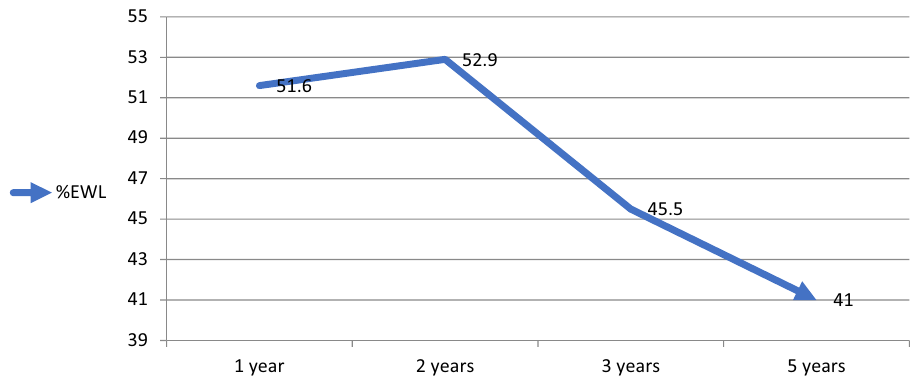
Figure 3. Trend of change in %EWL during 5 years after conversional OAGB through repeated measure test. %EWL percent excess weight